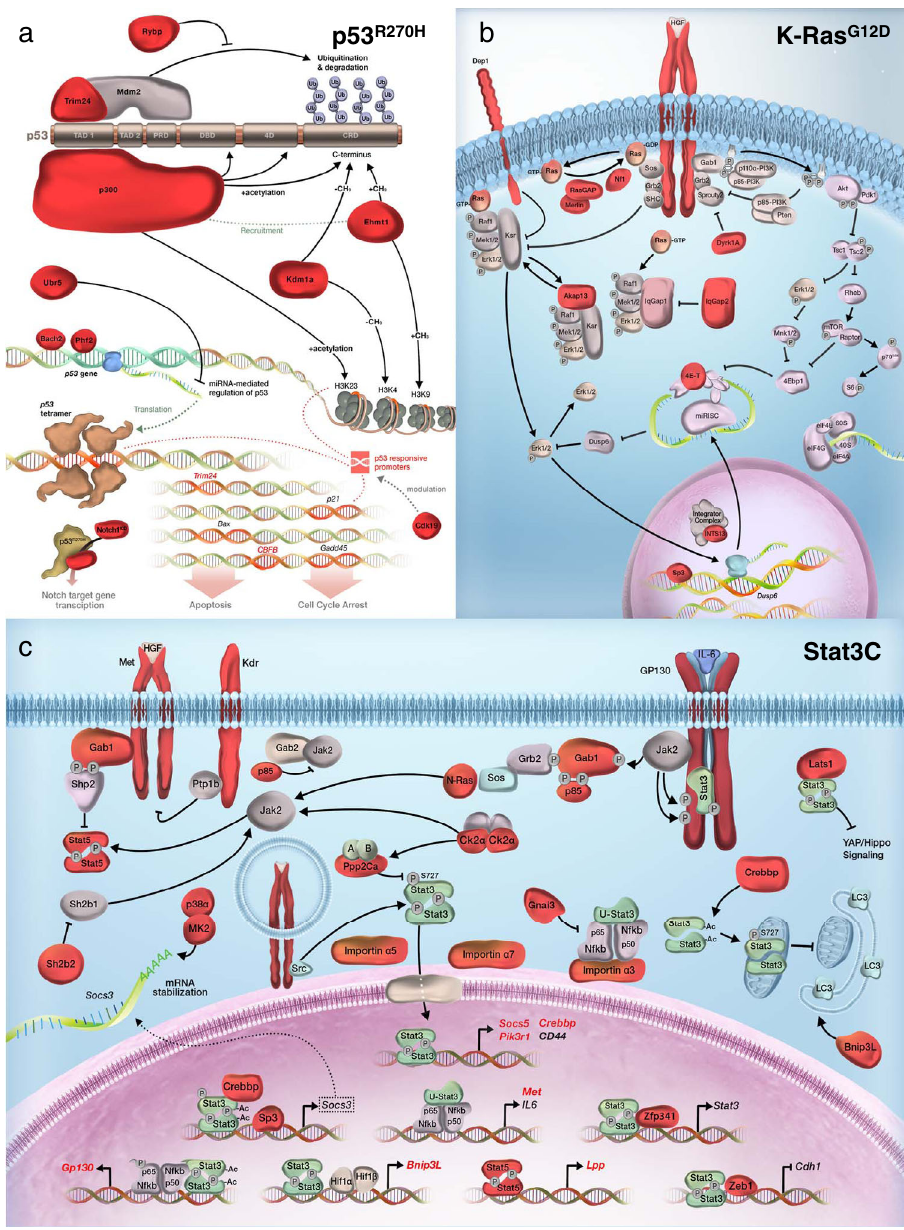
Fig. 9 Many gCIS function on the same pathway as the oncogenic driver responsible for tumor initiation. a – c Representative schematics highlighting molecular components of p53 ( a ), K-Ras ( b ), and Stat3 ( c ) pathways that were targeted for insertional mutagenesis in Trp53 R270H , K-Ras G12D , and Stat3C cohort tumors, respectively. gCIS encoded proteins identi fi ed on each background are highlighted in